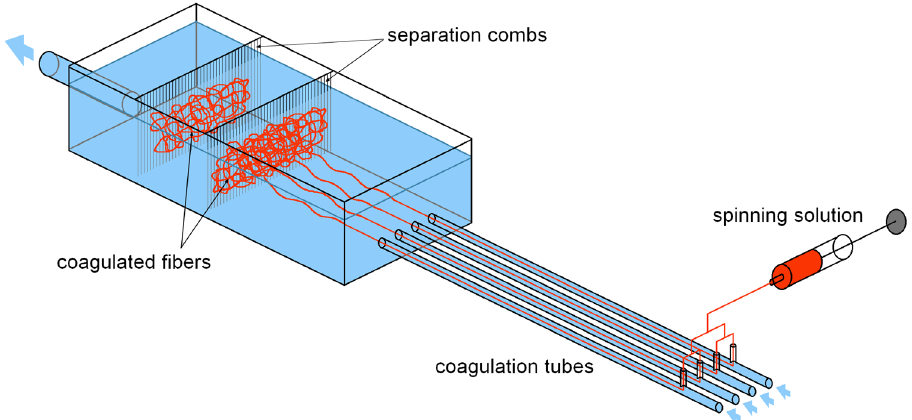
Figure 2. Schematic depiction of the spinning apparatus. The HA solution is dosed into 4 nozzles, each placed in a separate coagulation tube, perpendicular to the coagulation bath flow. The tubes lead into a larger vessel with separation combs, which are used to separate the coagulated fibres from the circulating bath.